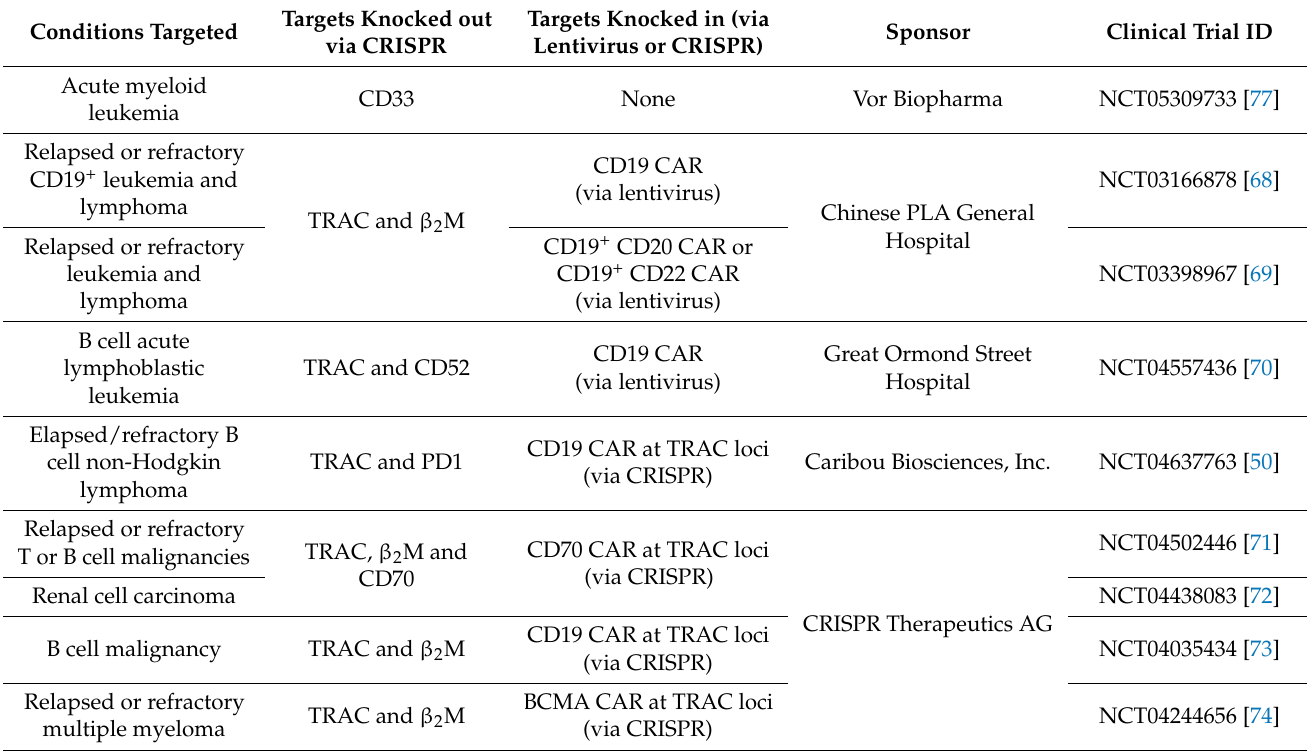
Table 2. List of allogenic cellular immunotherapies using the CRISPR-Cas9-based gene editing